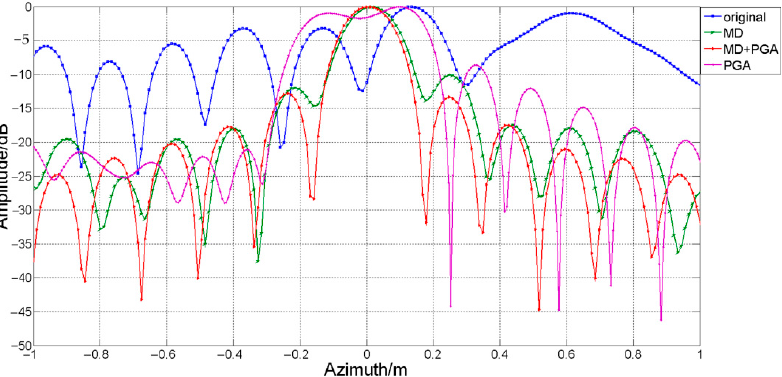
Figure 19. Azimuth profile of point a , a (cid:48) , a (cid:48)(cid:48) and a (cid:48)(cid:48)(cid:48) .